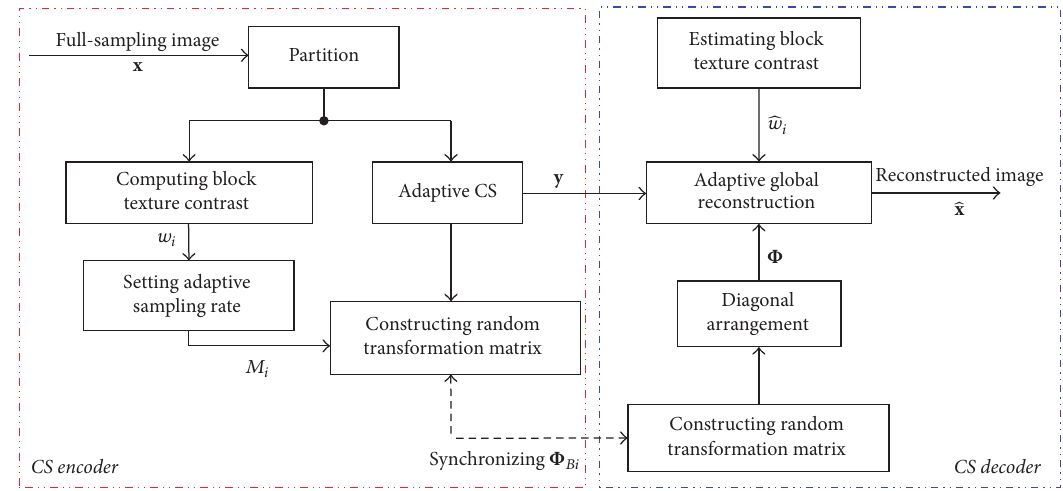
Figure 2: Flow of the proposed